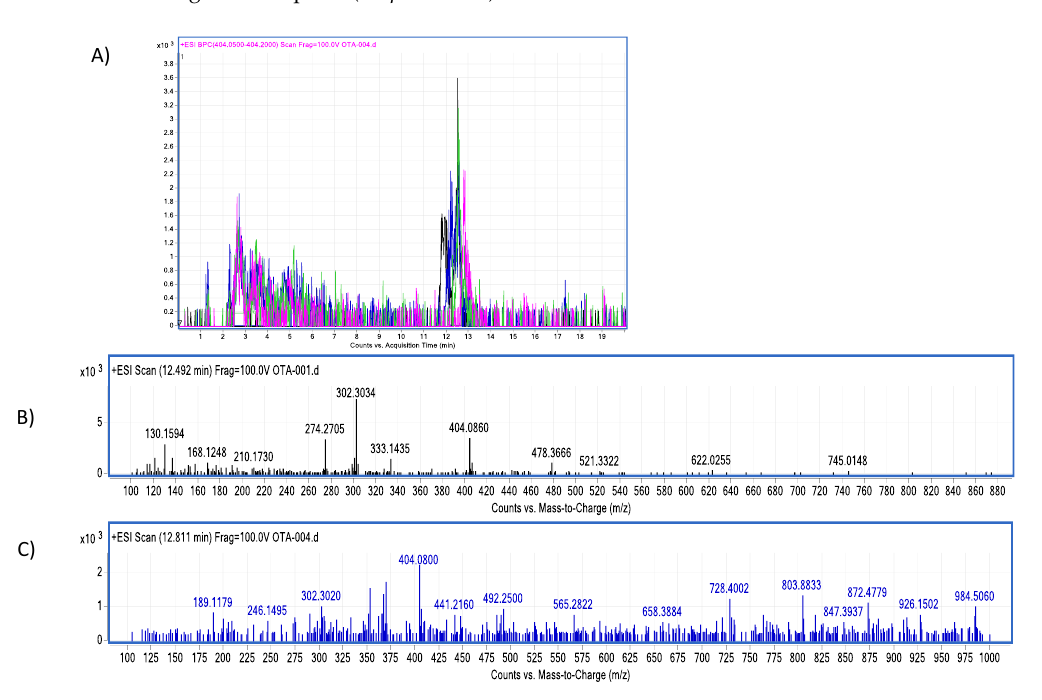
Figure 8. Bromelain–OTA biotransformation HPLC–TOF–MS chromatograms showing: ( A ) Ochra- toxin (OTA) control (black), experimental assay and replicates (blue, green and pink). ( B ) OTA’s molecular ion as found in control tubes (M + 1) at 404.08 ( m / z ); ( C ) OTA’s molecular ion as found in tested tubes (M + 1) at 404.08 ( m / z ). The molecular ion (M + 1) of α -ochratoxin was not detected (fragmentation at 212.85 m / z